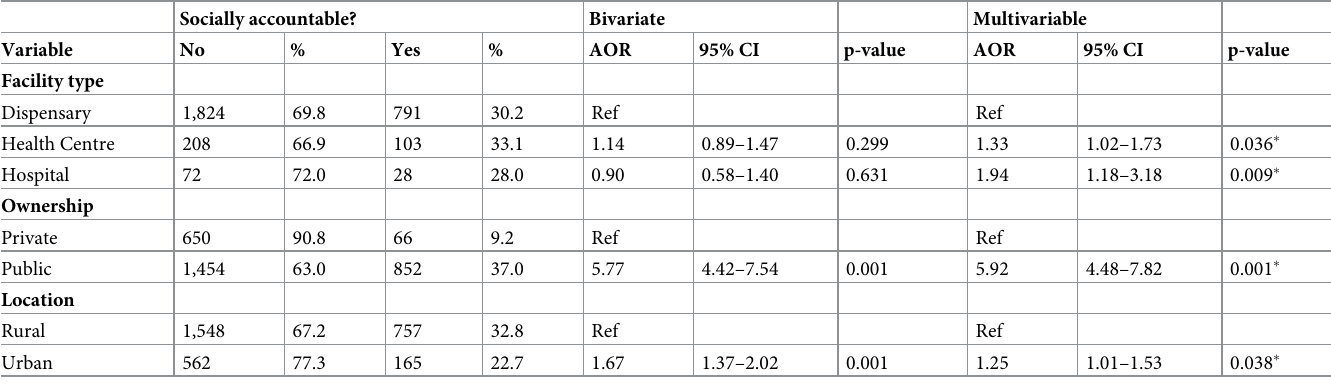
p- Values are calculated using chi-square test. � Factors whose association were found significant in the final logistic regression model. Facility type, ownership and location were the variables used to adjust for the